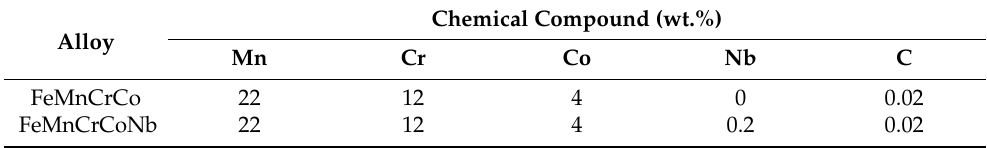
Chemical Compound (wt.%)